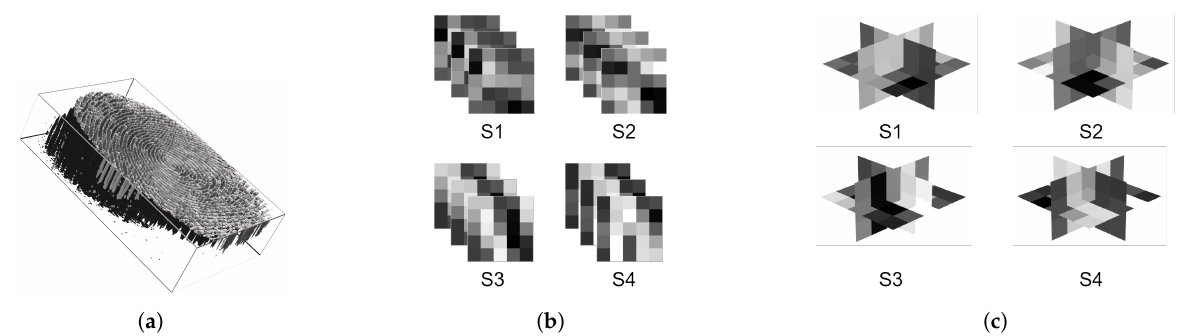
Figure 3. Illustration of 3-D sampling and decomposition. Fingerprint Video ( a ), 3-D patches sized (5 × 5 × 3) ( b ), and patches in b decomposed into xy, xt, and yt planes ( c ).